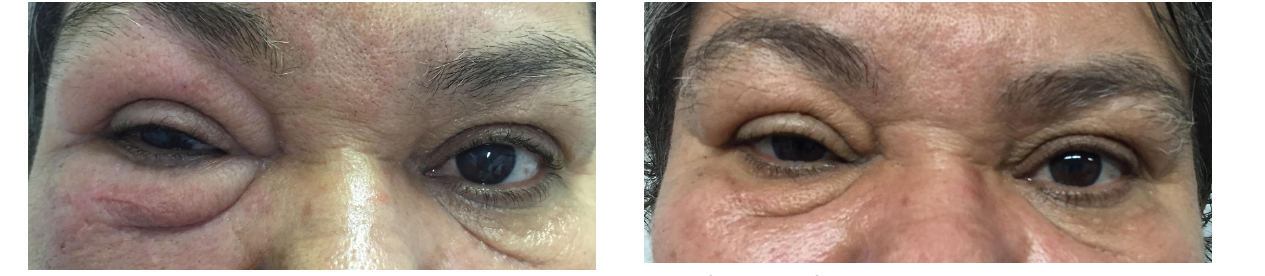
Figure 3: Aspect after treatment with tacrolimus; the patient is still being followed at our